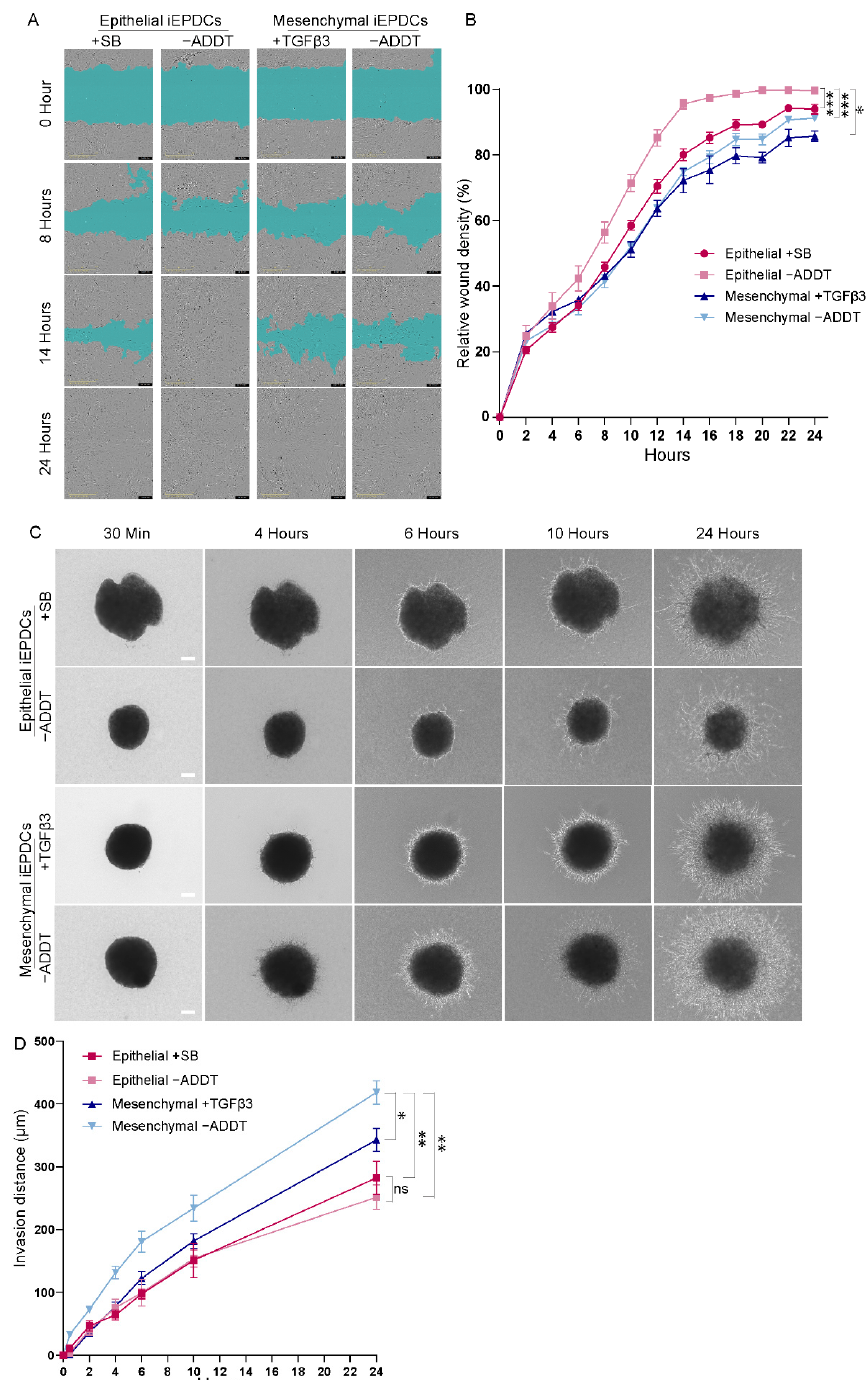
Figure 5. Mesenchymal iEPDCs show robust migration and invasion ability ( A ). Representative phase contract images of iEPDC migration in a scratch wound healing assay. Scale bar = 400 μ m. ( B ). Quantification of iEPDC migration in a scratch wound healing assay. ( C ). Representative images of iEPDC aggregates in a 3D collagen gel-based invasion assay. Scale bar = 100 μ m. ( D ). Quantification of EPDC invasion distance within 24 h. The assay was performed in Dox-free complete medium with the indicated additives using either epithelial iEPDCs (i.e., iEPDCs pretreated with SB (10 µ M) to preserve their cuboidal epithelial morphology) or with mesenchymal iEPDCs (i.e., iEPDCs pretreated for five days with TGF β 3 (1 ng/mL) to induce a spindle-like morphology). * p < 0.05, ** p < 0.01, *** p < 0.001. − ADDT = no